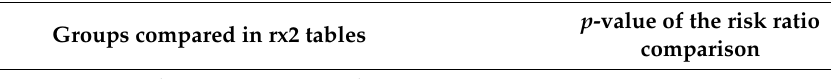
Vaccinated vs. Non-vaccinated